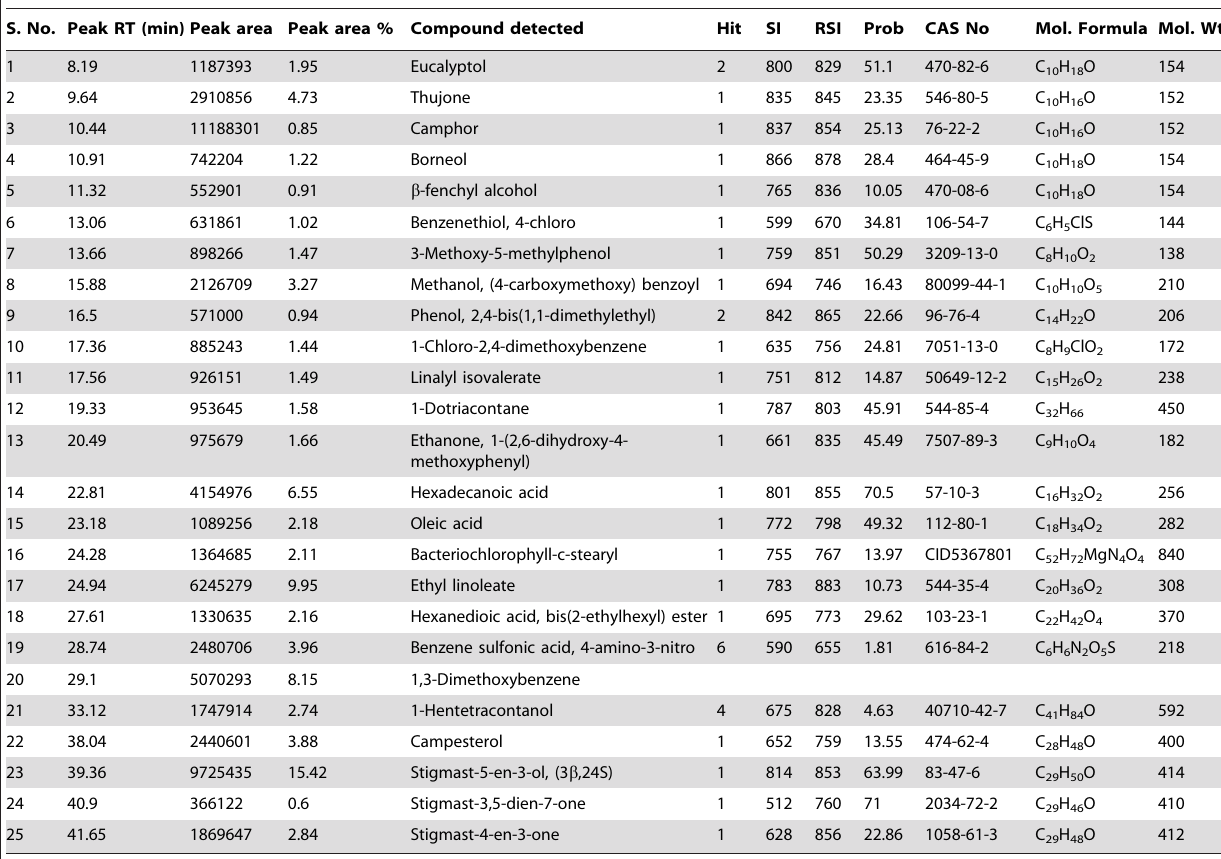
Table 3. Phyto-chemotypes identified in the dichloroethane root extract of R. imbricata by GC/MS.